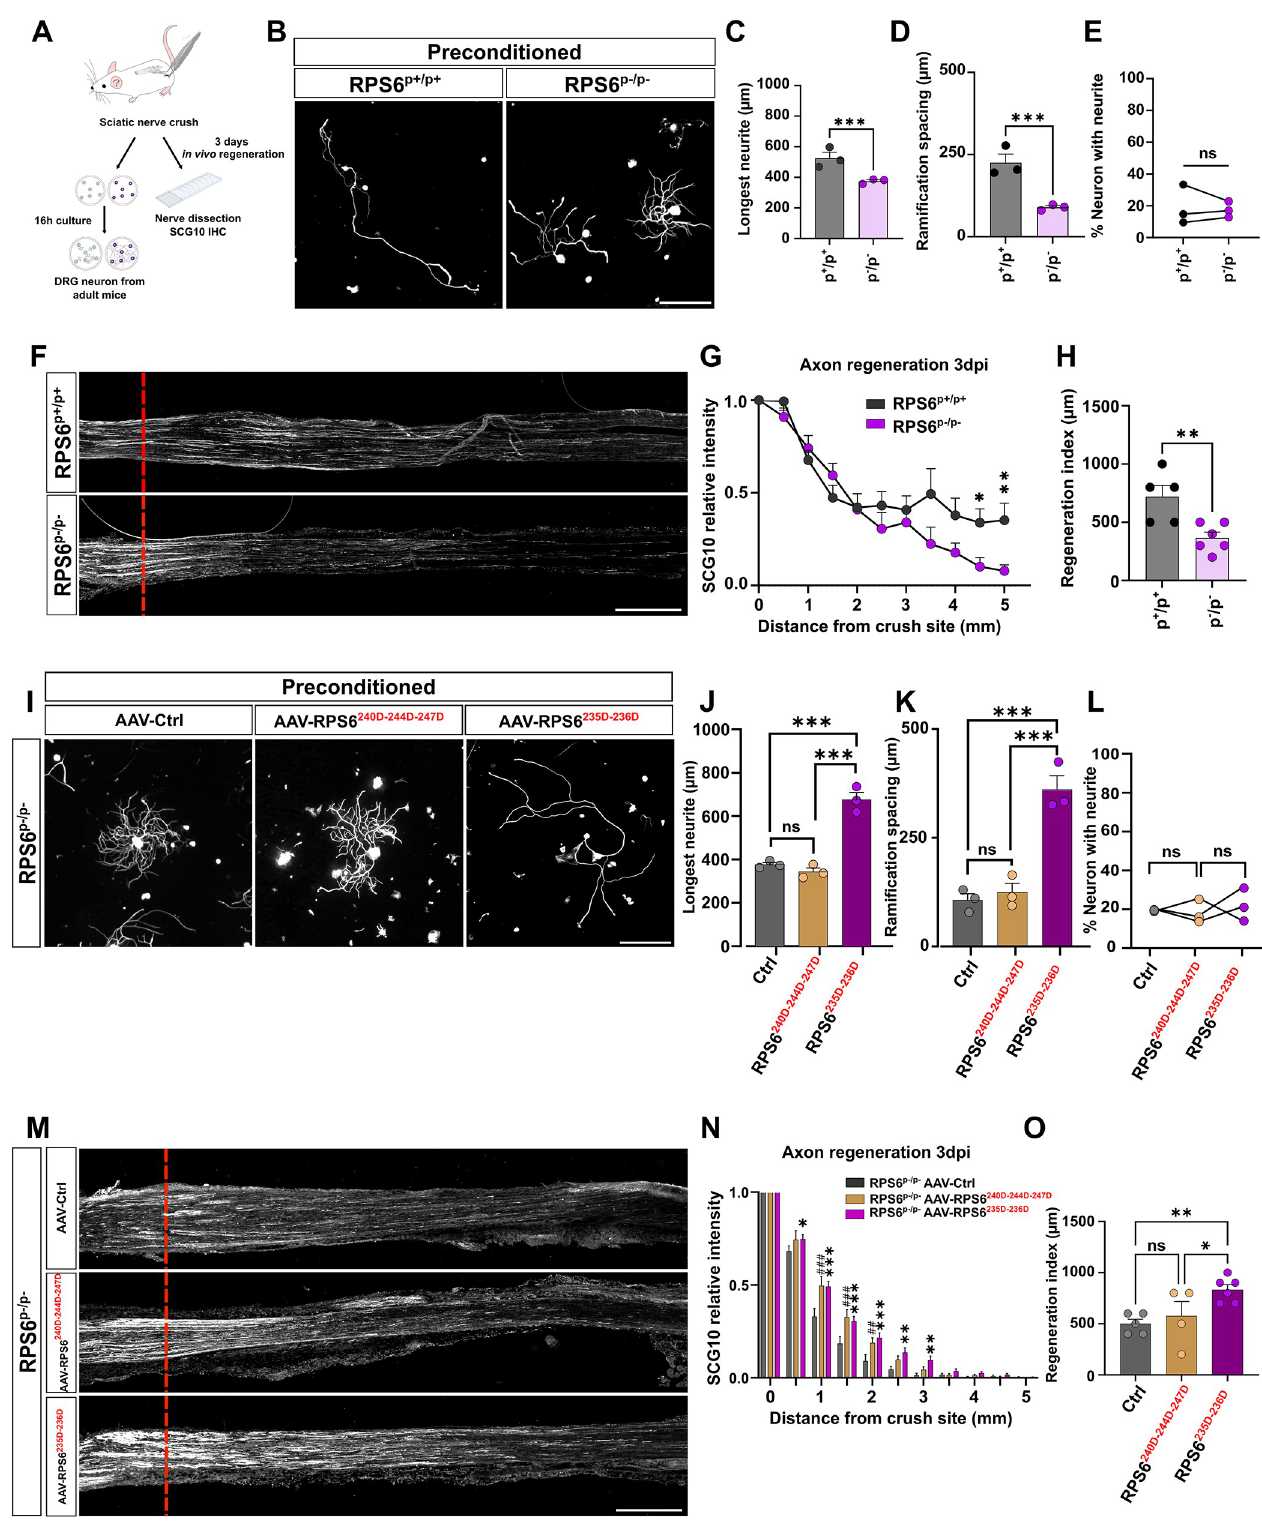
Fig 2. RPS6 phosphorylation on Ser 235–236 is key for axon regeneration. (A) Workflow of unphosphorylable RPS6 mouse line analysis in the paradigm of preconditioning and sciatic nerve regeneration. (B) Representative microphotographs of preconditioned cultures of mature DRG neurons from WT (RPS6 p+/p + ) and homozygous (RPS6 p-/p- ) mice defective for RPS6 phosphorylation showing that the preconditioning effect is inhibited in RPS6 p-/p mice. Scale bar: